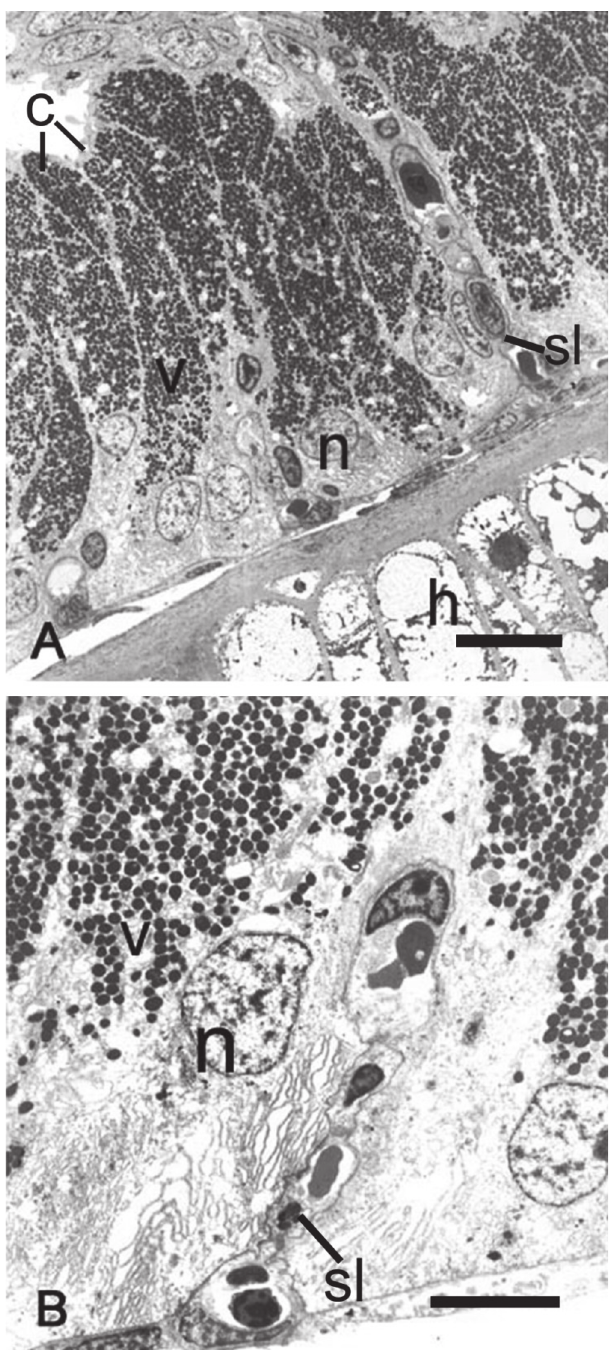
Fig. 5. Transmission electron micrographs (TEMs) of sagittal sections through gill glands of Compsura heterura . Tall columnar cells (c) are found between adjacent secondary lamellae (sl). Abundant electron-dense vesicles (v) occupy almost the whole cell; nuclei (n) are near the base of cells. h, hyaline cartilage. Scale bars: 8 µm (A), 5 µm